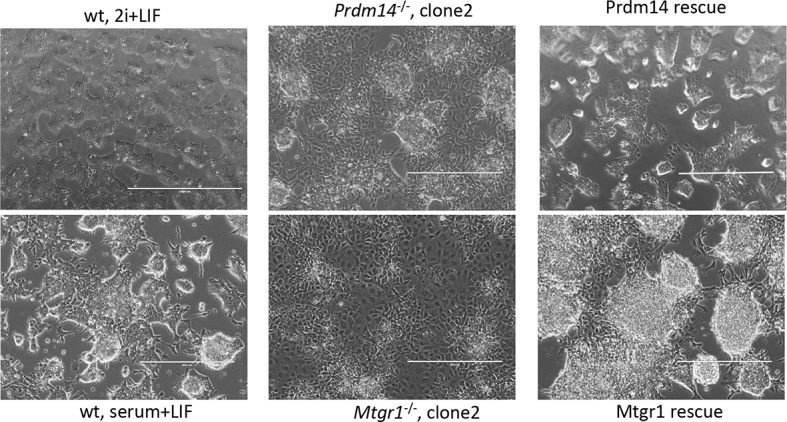
Morphological changes associated with loss of Prdm14 or Mtgr1.Brighfield images of cell morphology from wt ESCs, Prdm14−/− or Mtgr1−/−ESCs or those reconstituted with wt FH-Prdm14 or FH-Mtgr1, respectively, all grown under serum+LIF conditions; wt ESC maintained in 2i+LIF are included for relative comparisons (upper left image). ESC, embryonic stem cell; LIF, leukemia inhibitory factor; Mtgr1, myeloid translocation gene related 1; wt, wild type.